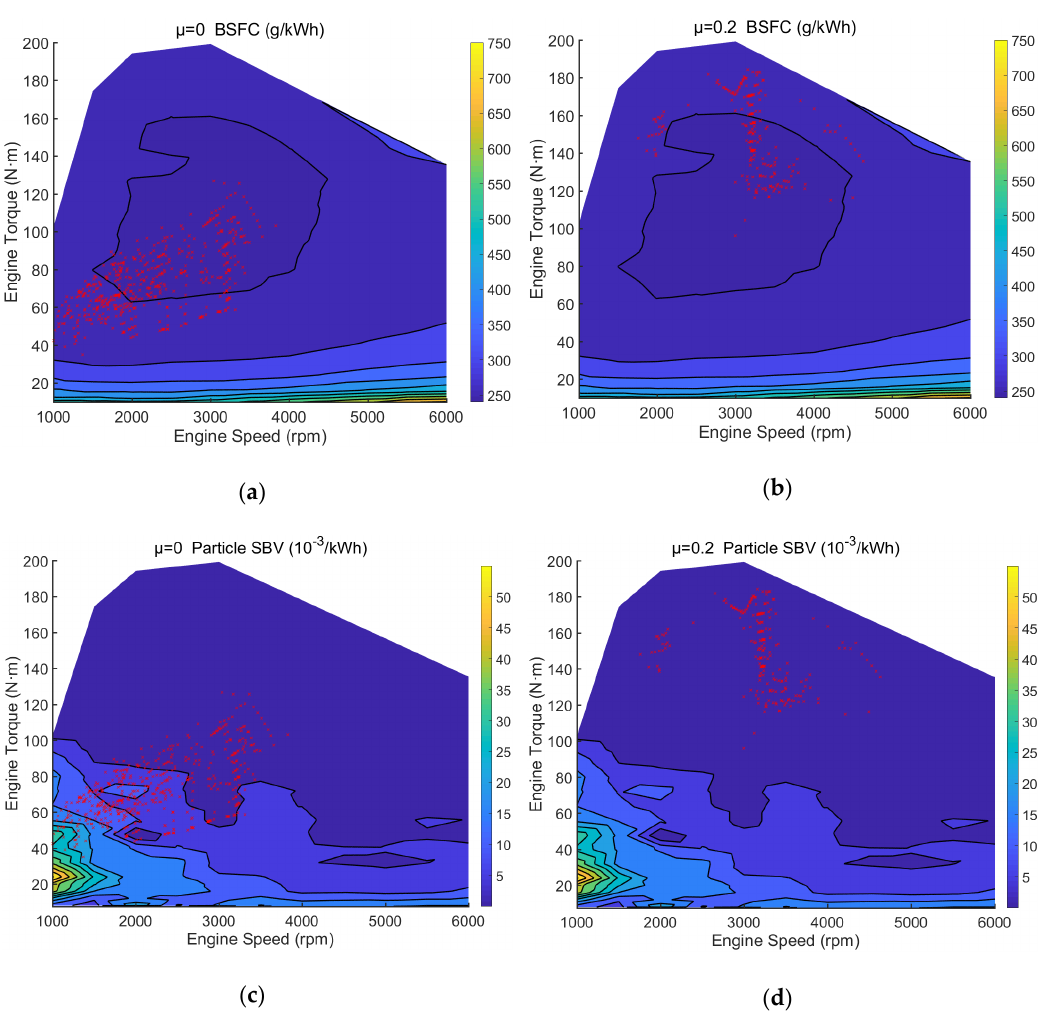
Figure 11. Comparison results of different weighting coefficients for emission particle. ( a ) 𝜇 = 0